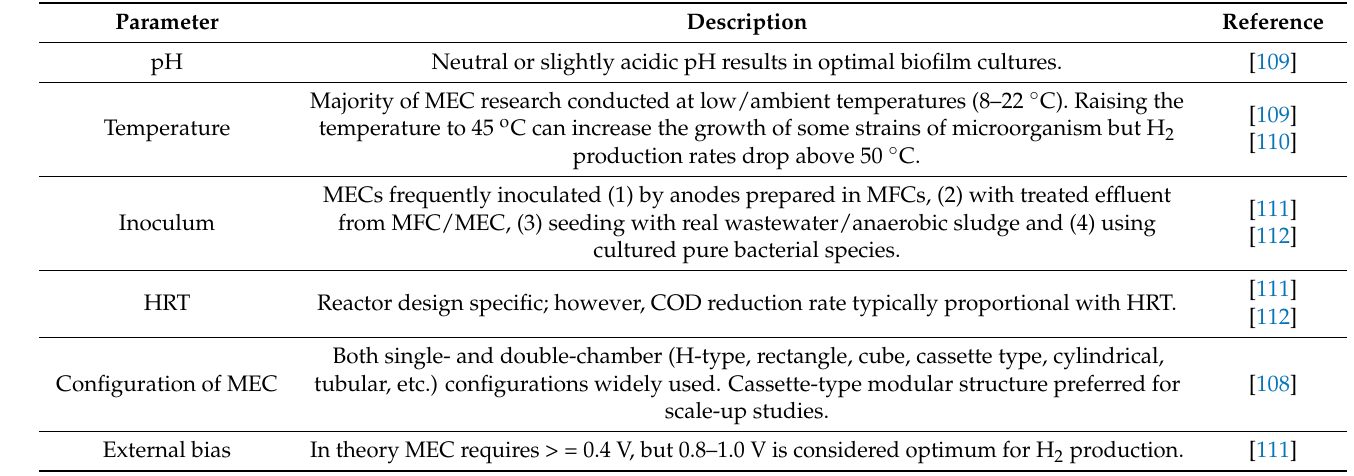
Table 11. Key parameters influencing H 2 production via